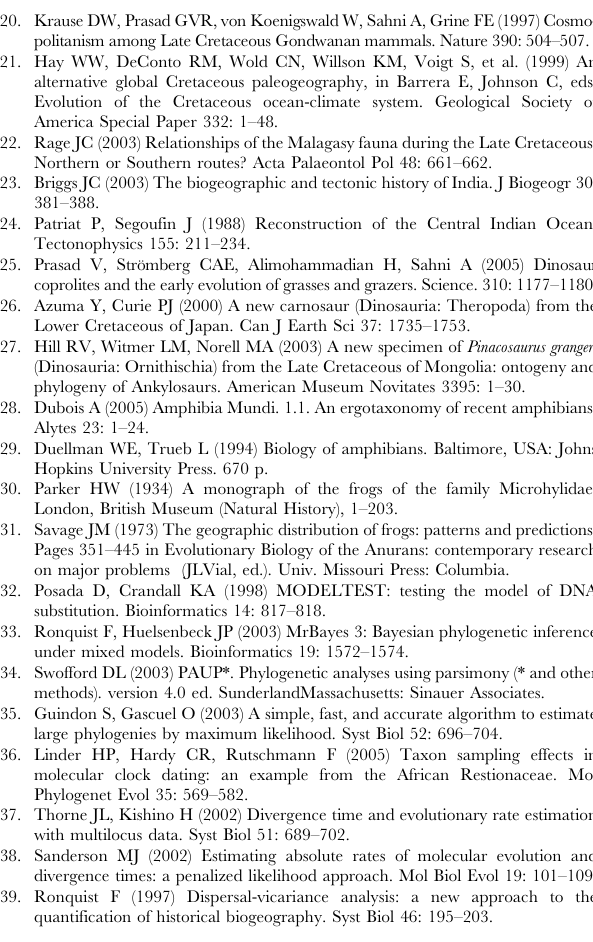
Table S9 Divergence time estimates (standard deviation; 95% credibility intervals) for all ingroup nodes in our dating-tree, obtained with different calibration points and dating methods.